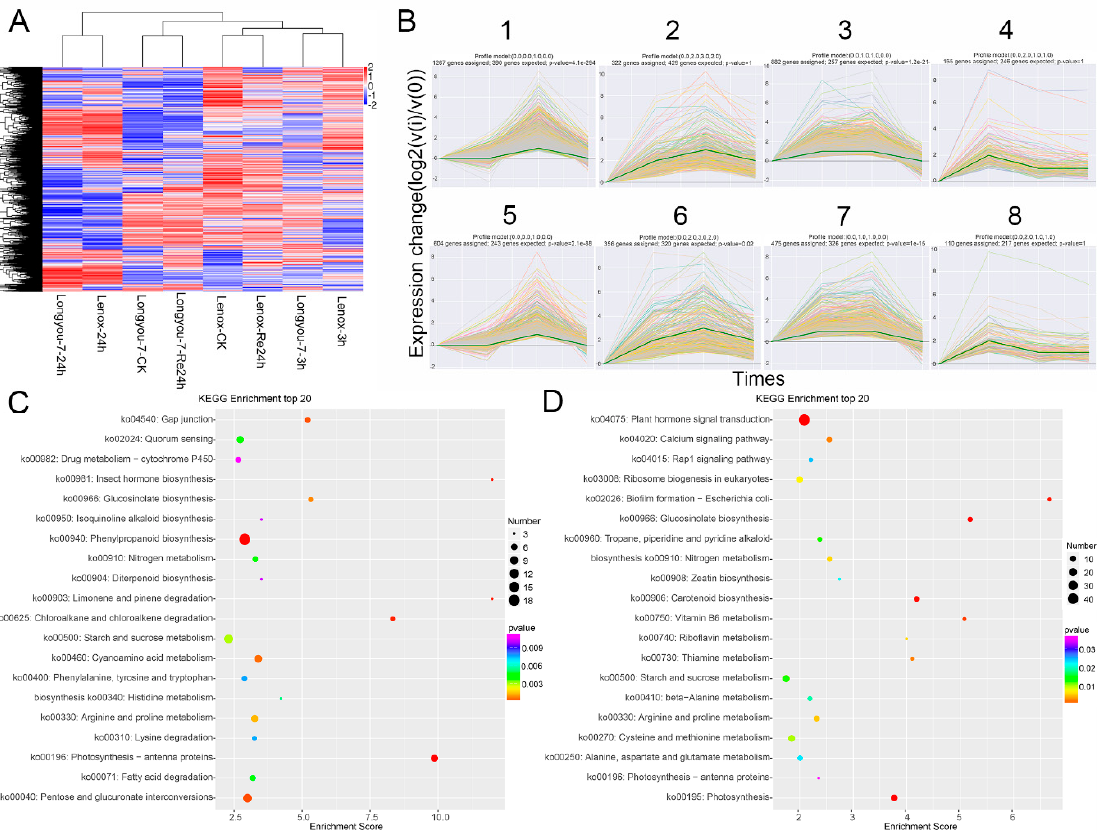
Figure 3. Expression profiles of DEGs for different treatments and annotations of the KEGG pathway. ( A ) Based on the log2-fold-change value of the comparison process and the control, hierarchical clustering of DEGs was performed for different treatments to obtain eight clusters; ( B ) eight representative expression patterns of eight clusters were screened; ( C ) KEGG-enriched DEGs in